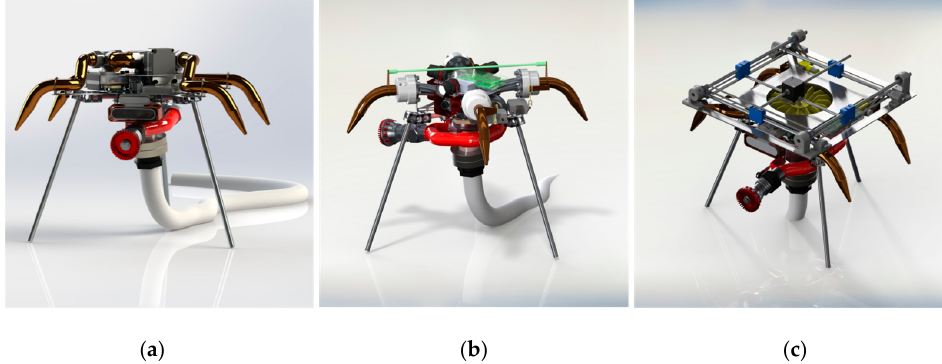
Figure 2. The proposed designs. ( a ) Flow rate control system; ( b ) Nozzle rotation control system; ( c ) Weight distribution control system.